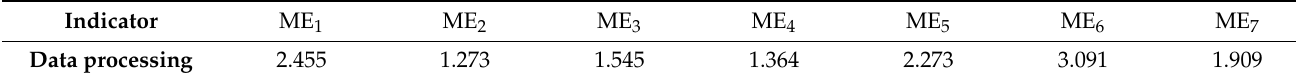
Table A5. Data processing of material and equipment risk (ME).